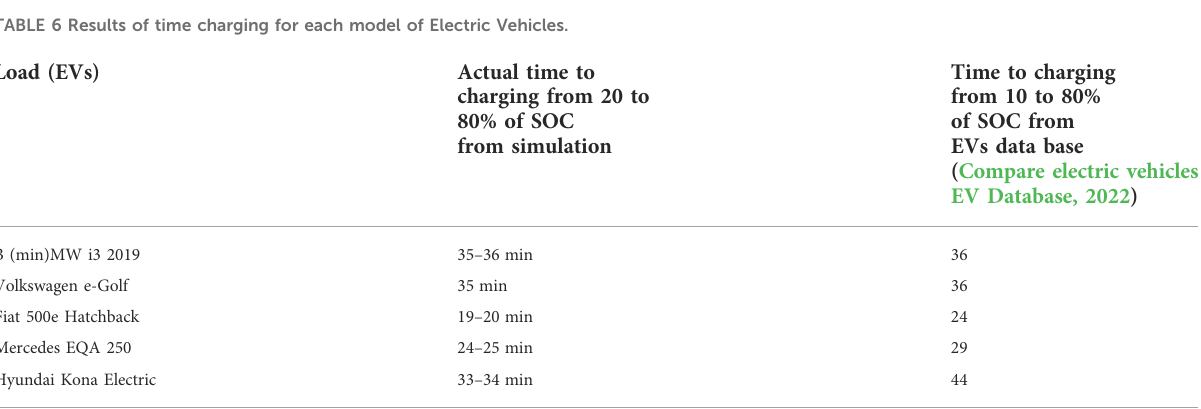
TABLE 6 Results of time charging for each model of Electric